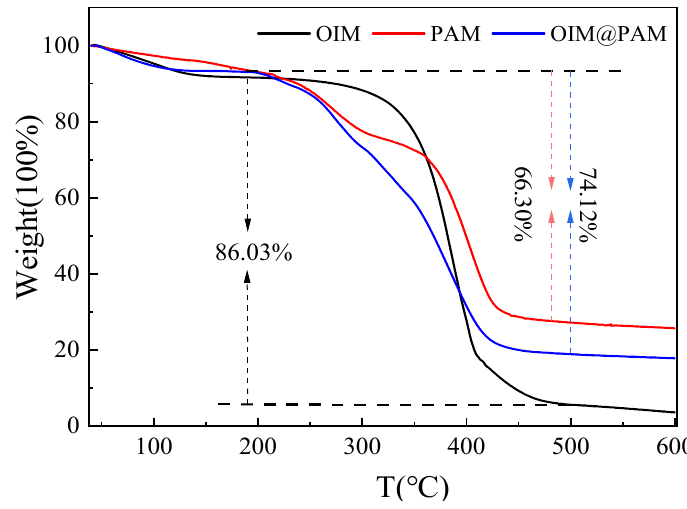
Figure 3. TGA curves of pure OIM , PAM and OIM@PAM.